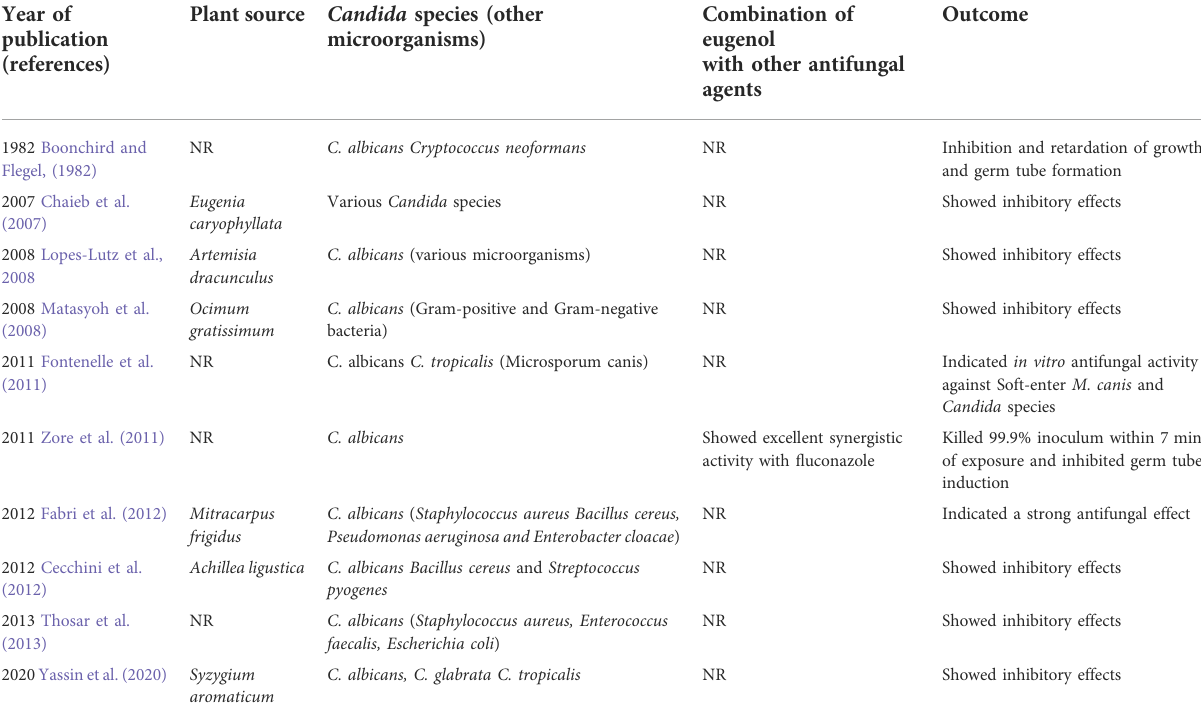
TABLE 1 Other studies that have used eugenol to inhibit Candida